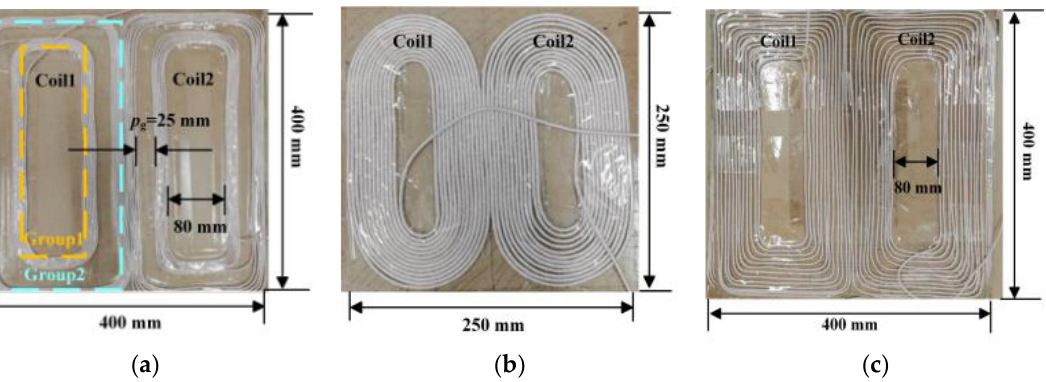
Figure 14. Experimental coils: ( a ) Combined transmitting coil; ( b ) Receiving coil; ( c ) Regular trans- mitting coil.